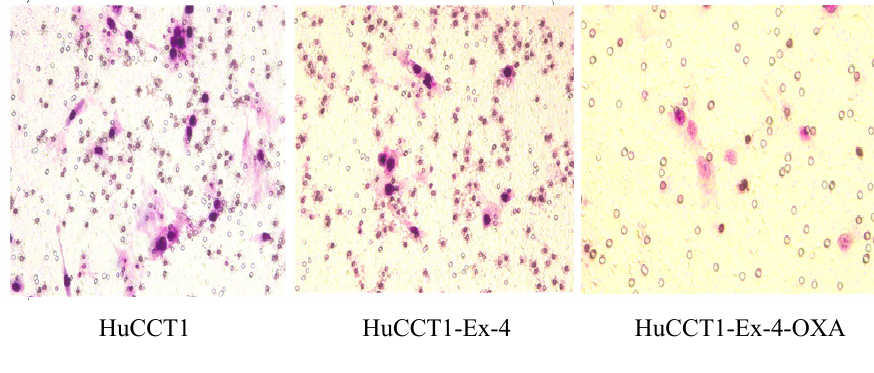
Figure 6. Transwell